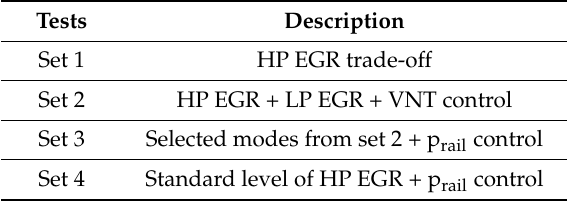
Table 2. Description of experimental activities.